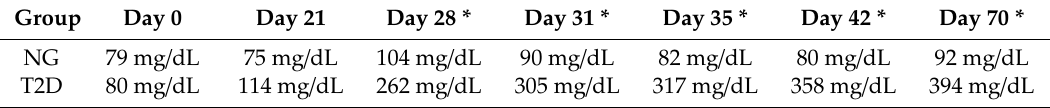
Table 2. NG and T2D glycemia average at evaluated periods.